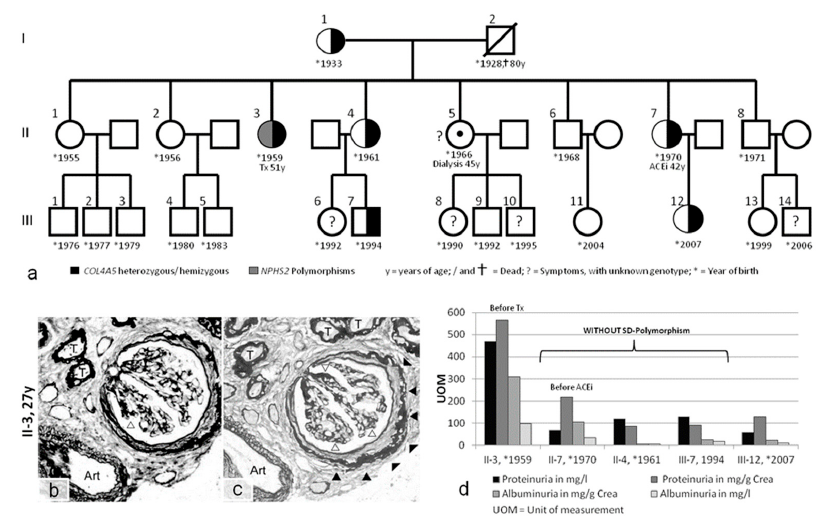
Figure 3. ( a ) Pedigree of case 3, with I-1 and family members (II-1, II-2, II-5, II-6, and II-8) living in Poland. Further evaluation was performed on family members living in Vienna (II-3, II-4, II-7, III-7, and III-12). Tx = kidney transplant. ( b , c ) Kidney biopsy in case II-3. Only a small core of renal tissue could be obtained for light microscopy. This tissue contained only one relatively intact glomerulus and three glomerular scars. The pathology was described as nonspecific and dominated by sclerosis. The glomerulus showed segmental scarring of the capillary loops (open arrowheads) and pronounced periglomerular fibrosis (solid arrowheads). The tubules (T) were dissociated by interstitial fibrosis, and thickening of the tubular basement membranes confirmed advanced atrophy. One small artery (Art) exhibited minimal intimal fibrosis. ( d ) Proteinuria and albuminuria in family members with and without additional slit diaphragm (SD) polymorphisms. Methenamine silver ( b ) and PAS staining ( c ); magnification: 400×.